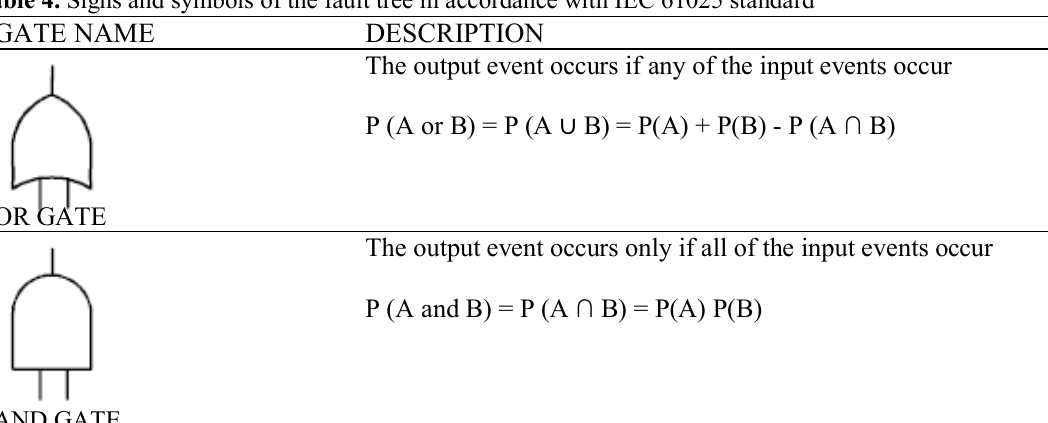
Table 4. Signs and symbols of the fault tree in accordance with IEC 61025